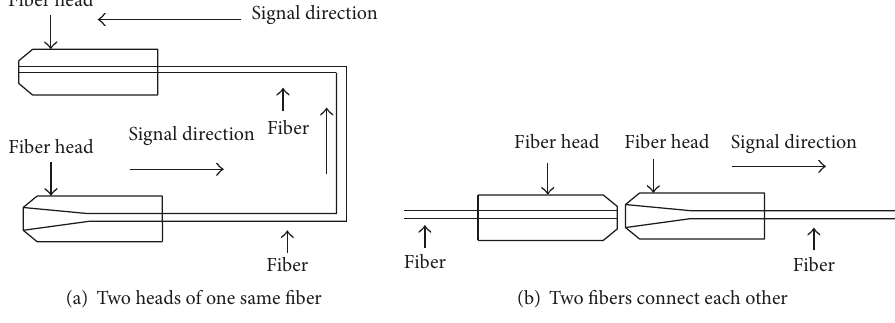
Figure 3: The structure of the directional tapered communication fiber connector.